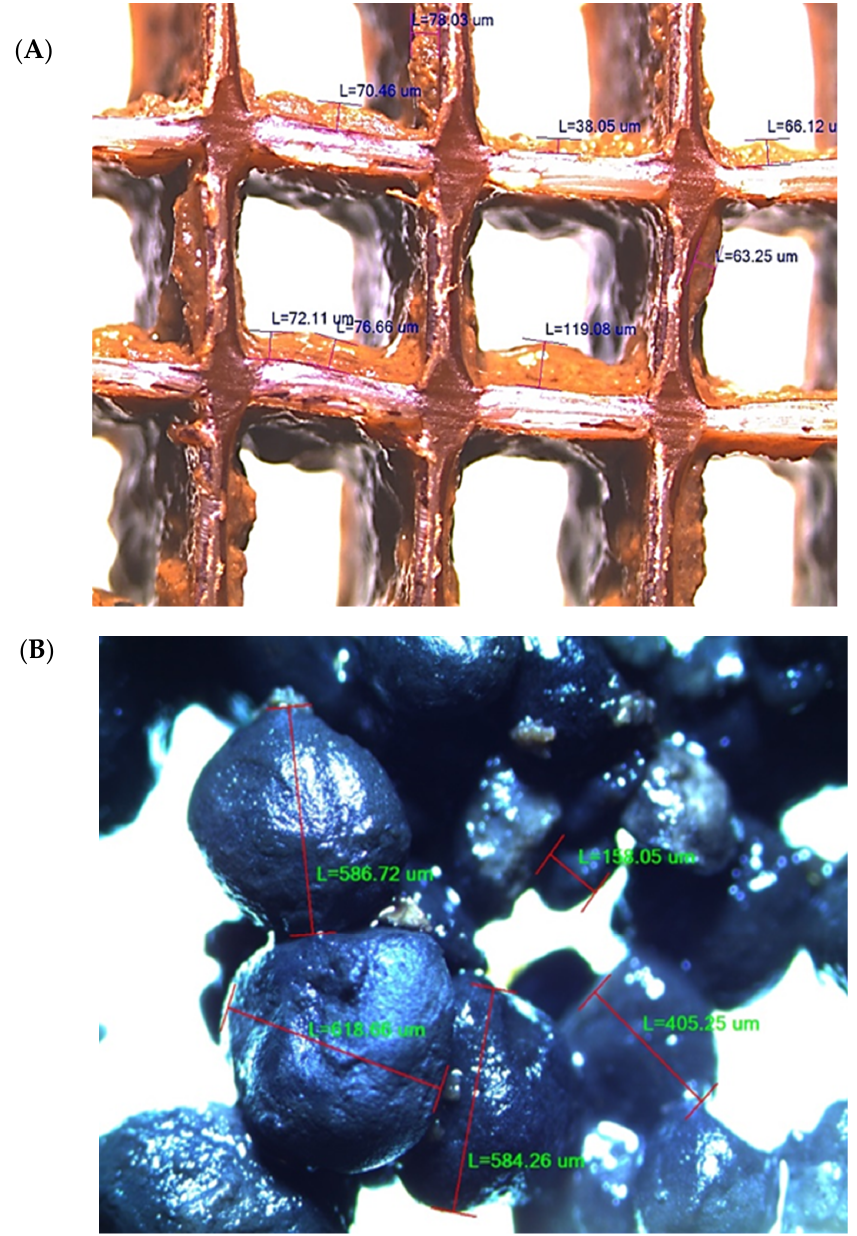
Figure 10. Stereo microscopic images captured via the Infinity Lumenera camera and measured by the Infinity Analyze software: ( A ) A HyVAB carrier (grid size; 500 × 500 µ m) and ( B ) the HyVAB AD granular sludge (scale shown as diameters (L) of granules).